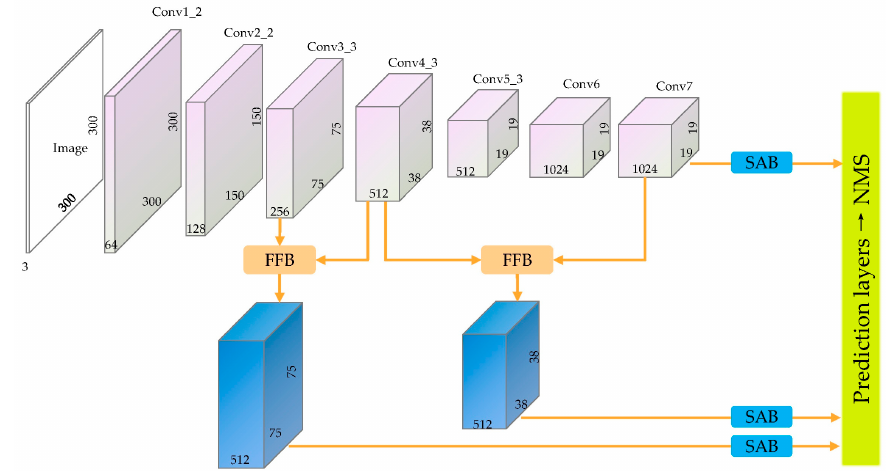
Figure 3. Schematic of the architecture of a simplified FASSD version for small object detection.